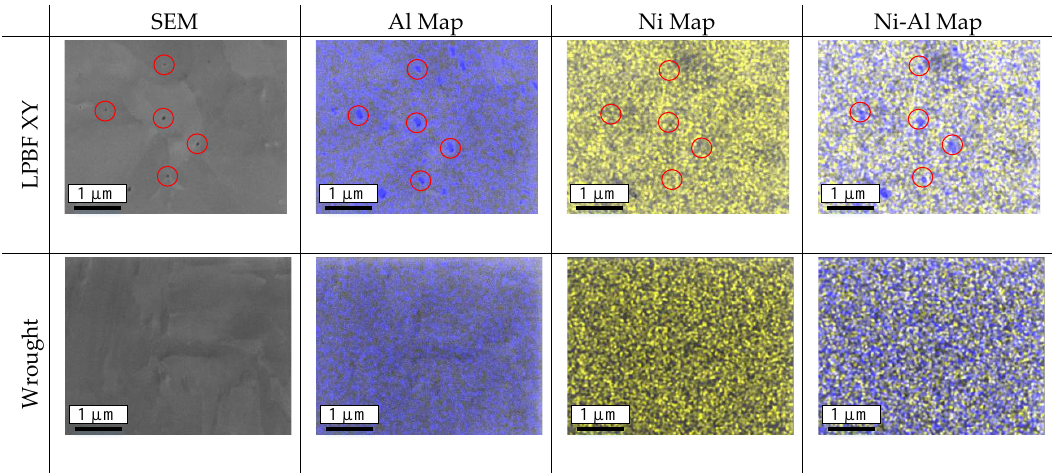
Figure 9. EDS composition maps for Ni and Al of the LPBF and wrought alloys in the 2 h-aged state.